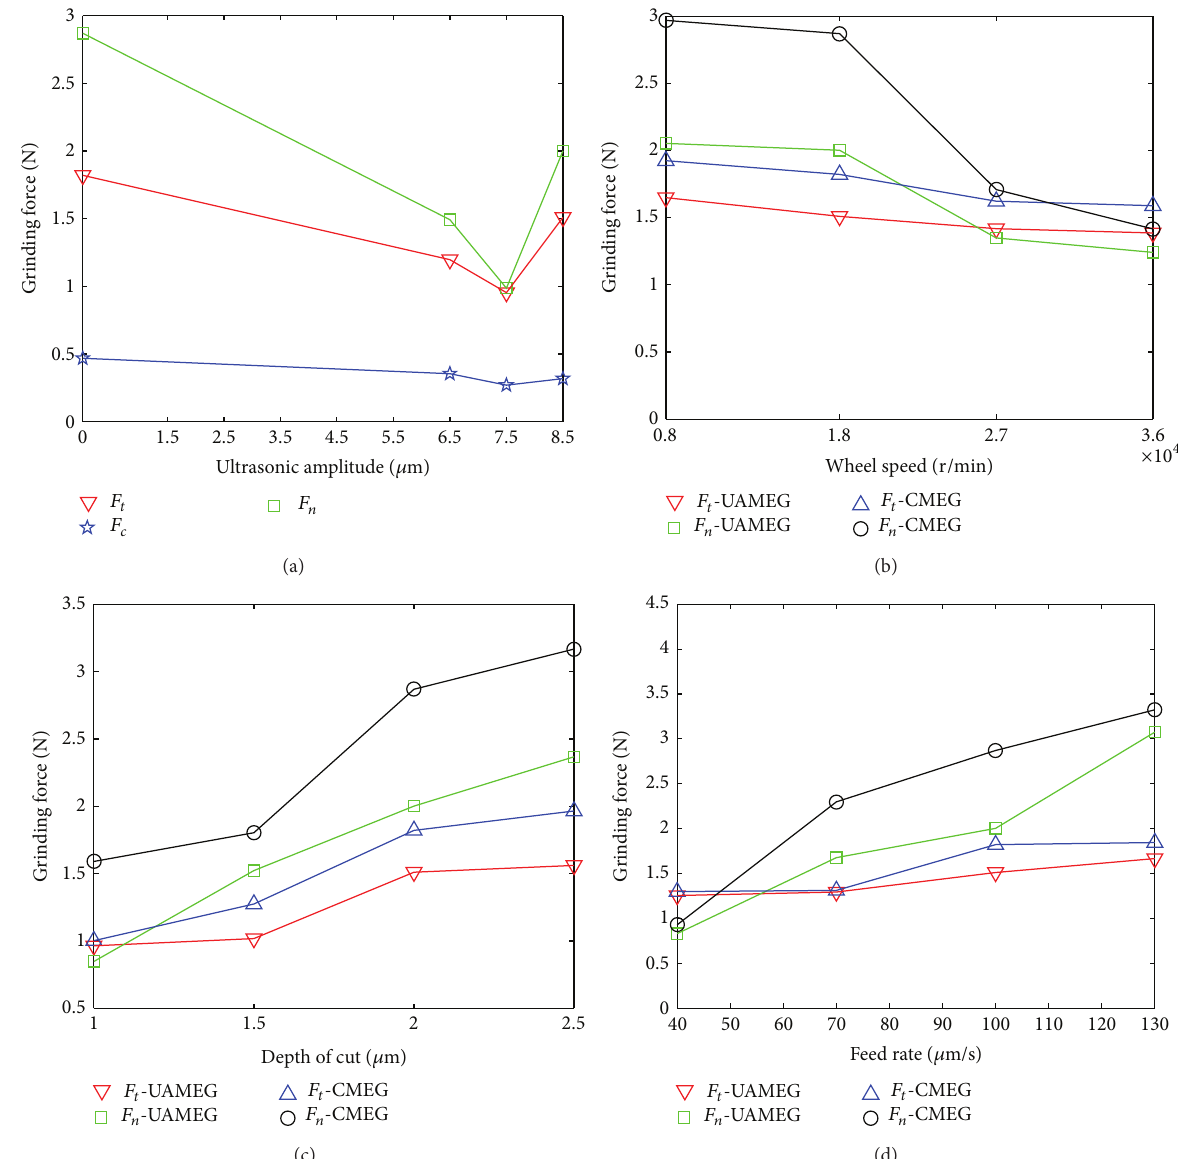
Figure 9: Effects of ultrasonic amplitude and grinding parameters on grinding forces. (a) Effects of ultrasonic amplitude ( V 𝑤 = 100 𝜇 m/s, = 2 𝜇 m, 𝑛 = 18000 r/min). (b) Effects of wheel speed ( V 𝑎 𝑝 𝑛 = 18000 r/min, 𝐴 = 8.5 𝜇 m). (d) Effects of wheel feed rate ( 𝑎